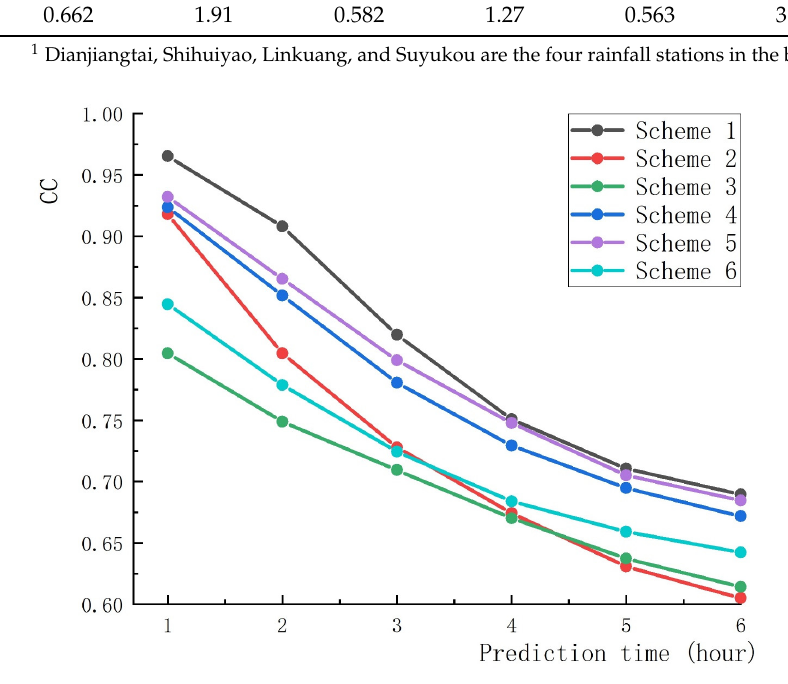
Figure 4. The correlation coefficient ( CC ) of the hourly rainfall forecast in Suyukou station. When the rainfall threshold was 10 mm and 15 mm, CSI , FAR , and POD of hourly rainfall prediction were calculated, as shown in Figures 5 and 6, respectively. It can be seen from the figures that all indicators change little when k = 10 mm and k = 15 mm in the same scheme. It can be found that with the increase in the length of the prediction period, the performance of each index decreases, and the change is the greatest when the prediction period is 3 h. When the rainfall threshold is 10 mm, the CSI of Scheme 1 decreases from 0.75 to 0.47, and FAR rises from 0.09 to 0.42. Although the variation trend of POD was not as obvious as that of CSI and FAR , it also showed a general downward trend. This means that too long a forecast period will increase the uncertainty of nowcasting.